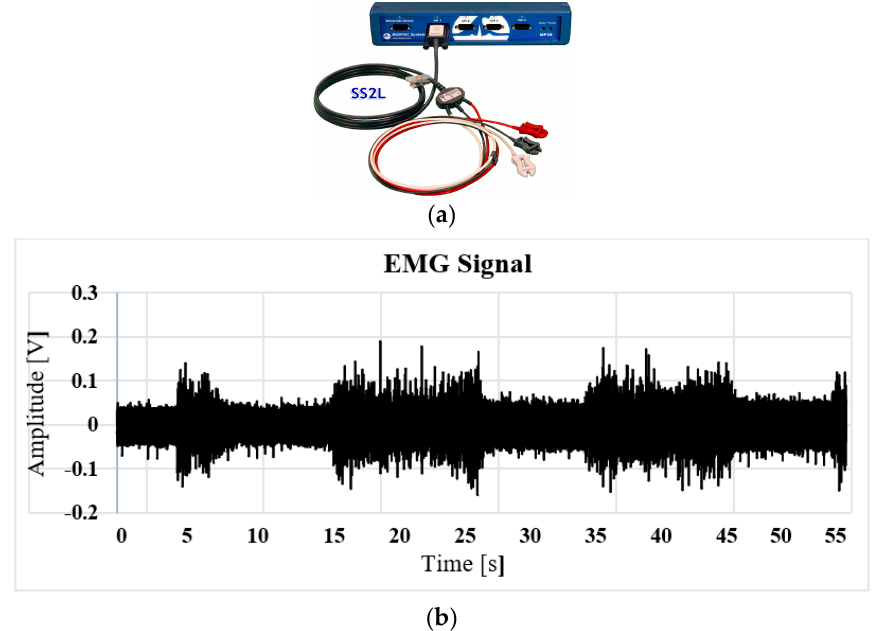
Figure 3. ( a ) Biopac ® System, ( b ) Database obtained from the Biopac of the EMG signal with sustained isometric contraction of 5 s.